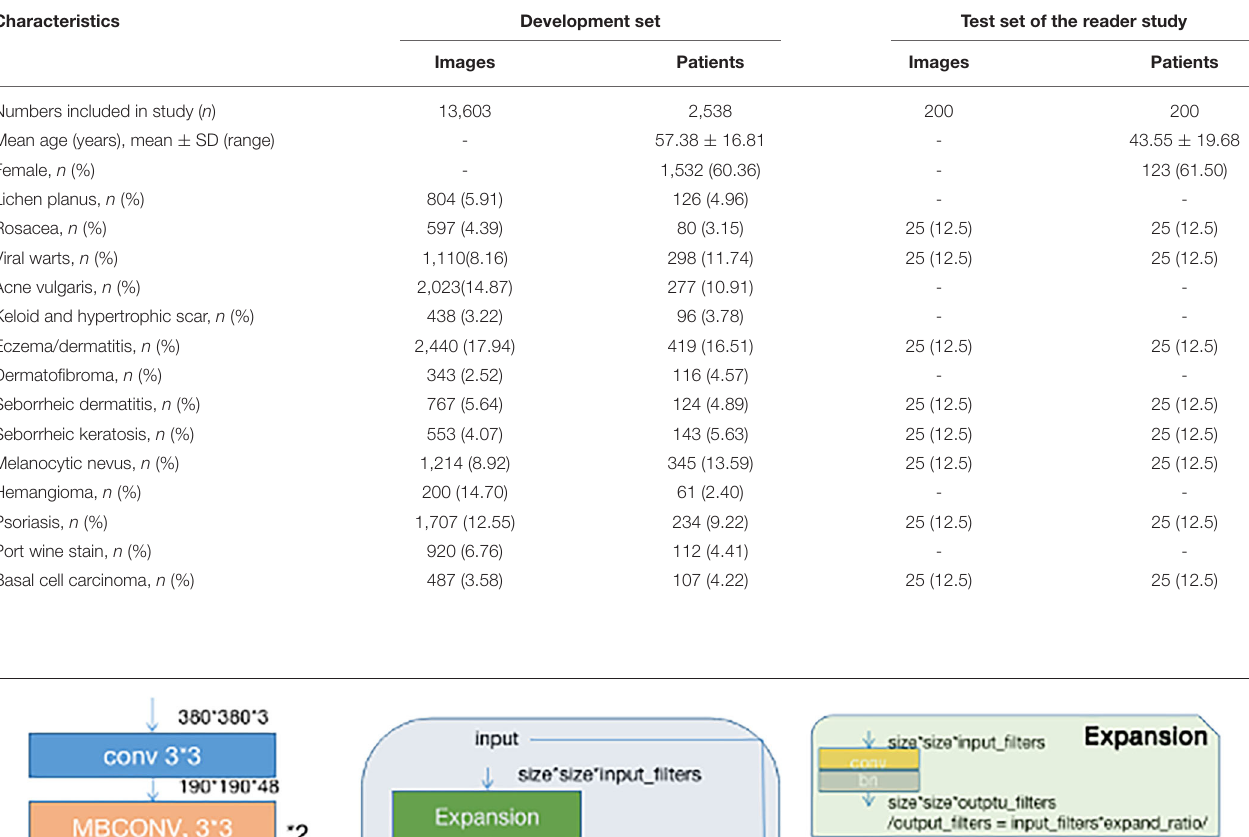
TABLE 1 | Dataset overview.